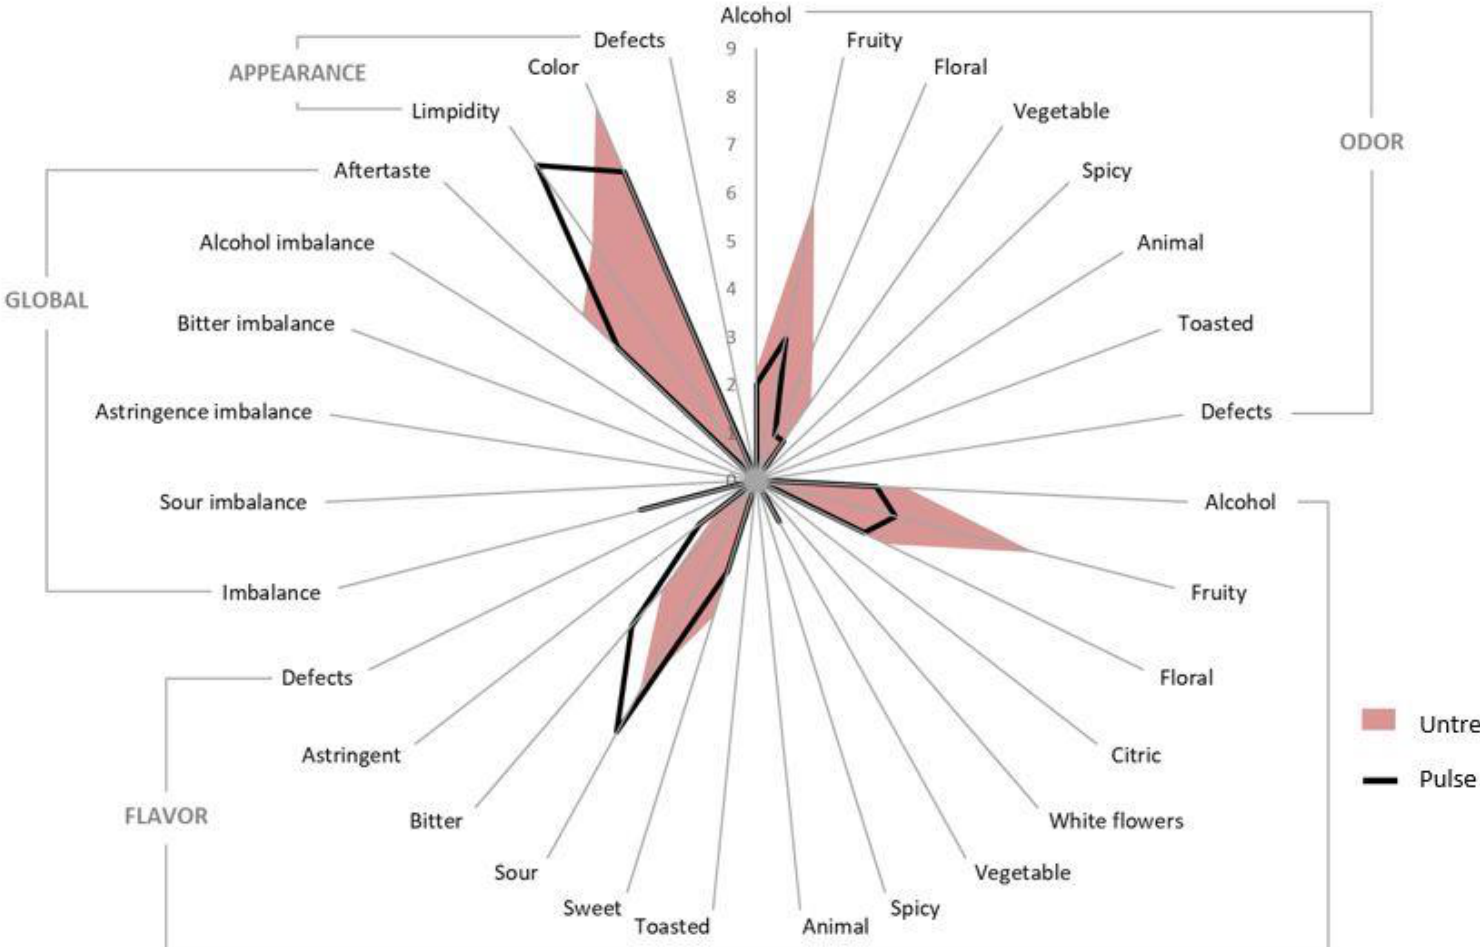
Figure 4. Sensory descriptive analysis of wine samples subjected to pulsed light (10.7 J/cm 2 ).